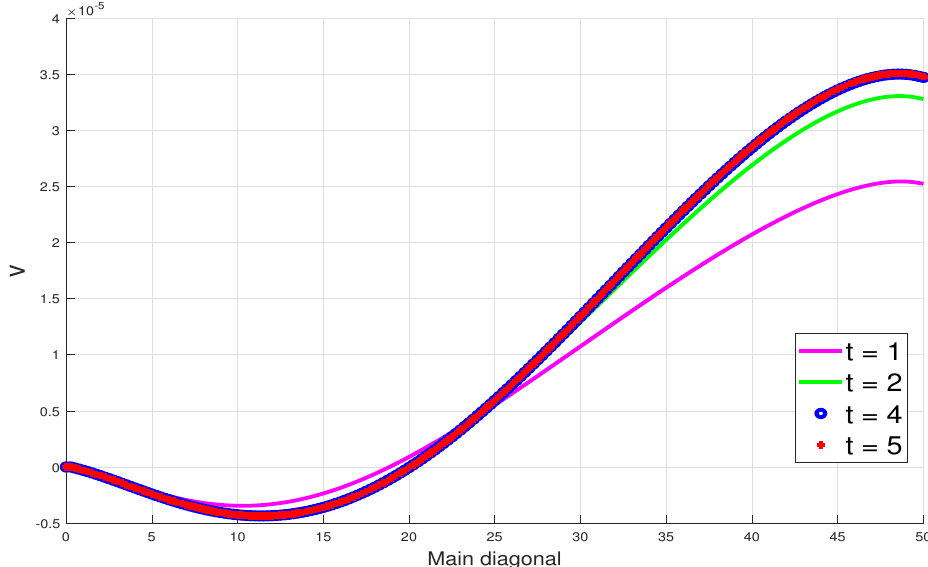
Figure 6. Time development of steady-state transverse velocity profiles.